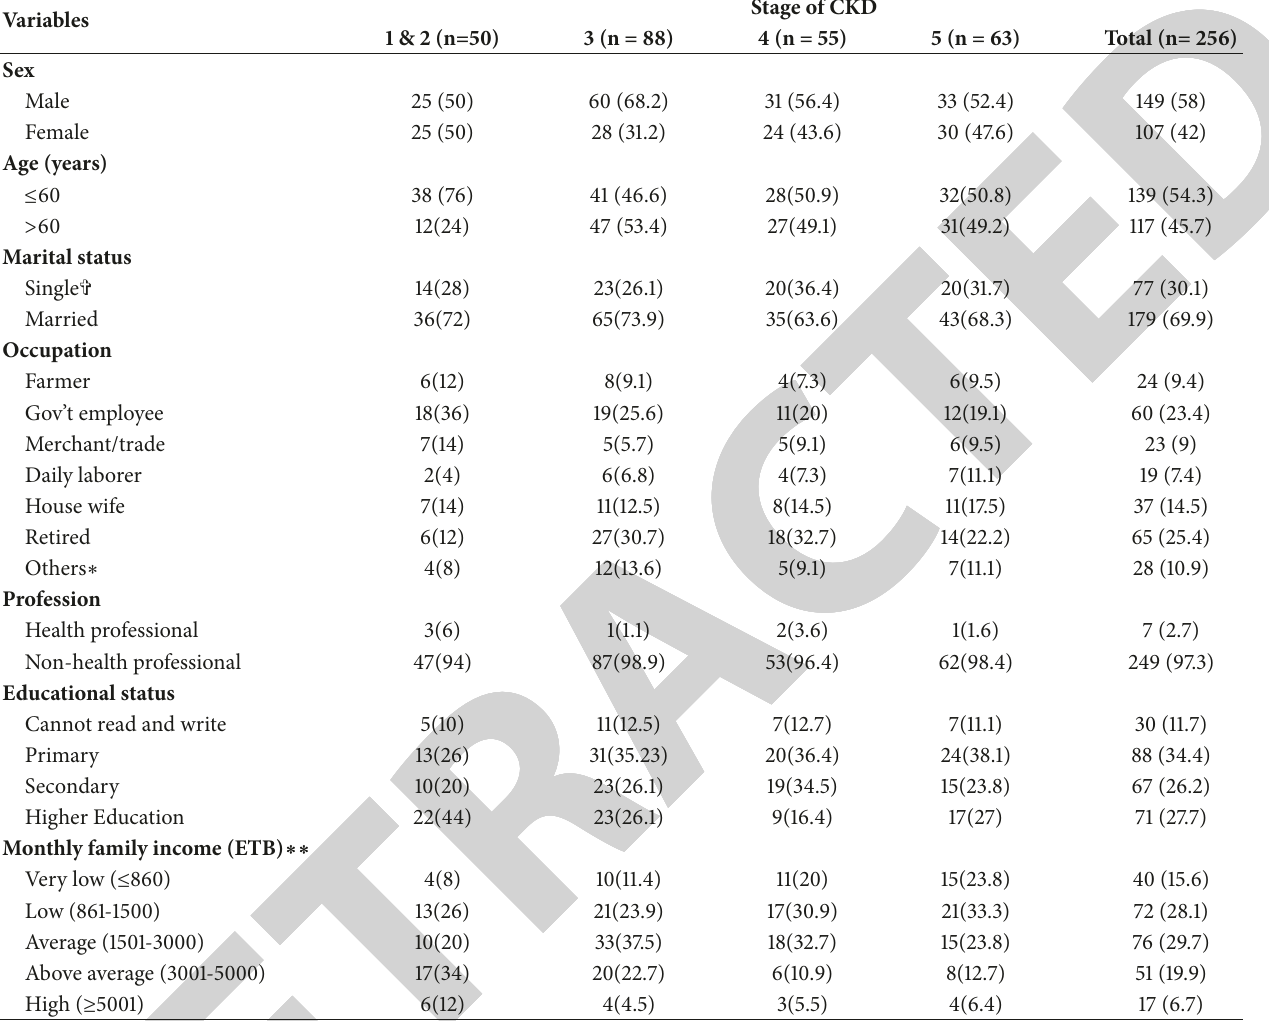
Table 1: Sociodemographic characteristic of chronic kidney disease patients attending the renal clinic of Tikur Anbessa Specialized Hospital.